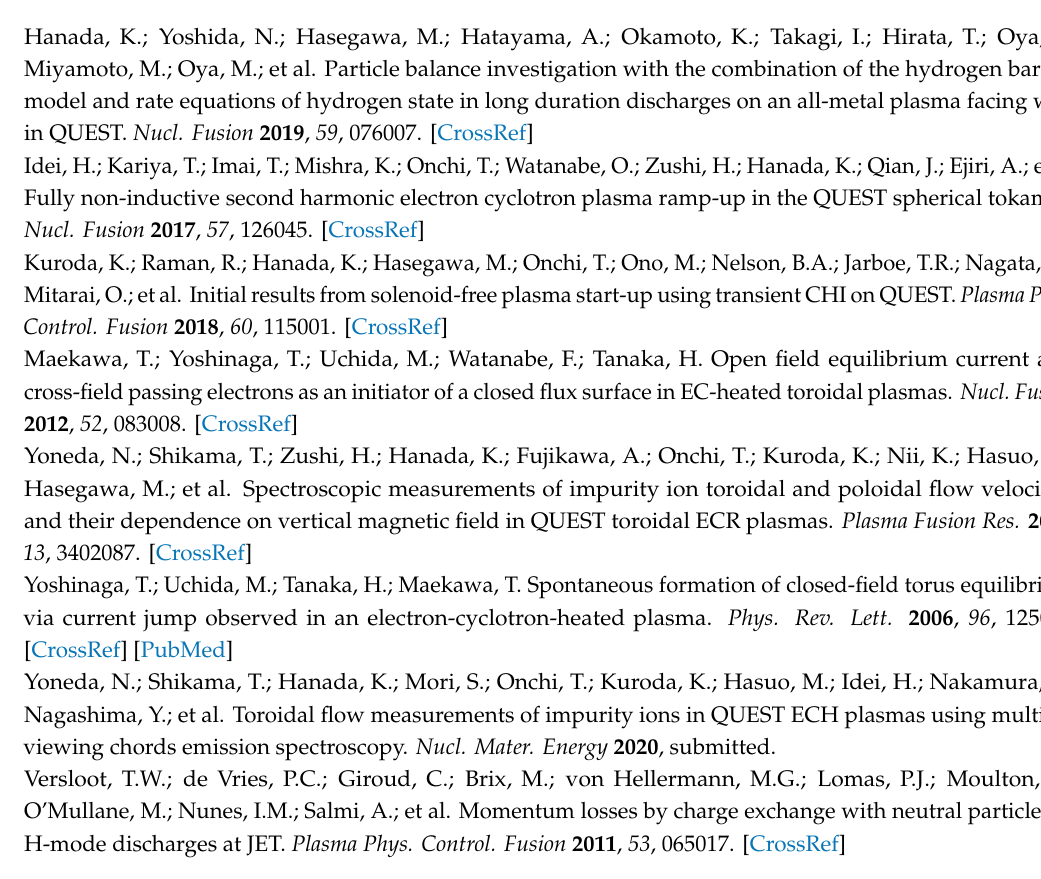
Figure 5a. The evaluated DOI shown in Figure 5b reached nearly unity over the entire core region, suggesting that the e ff ect of atoms on the core plasma is small. The DOI, however, decreased in the SOL region and this could induce the momentum loss of the ions trapped in orbits that intersect the